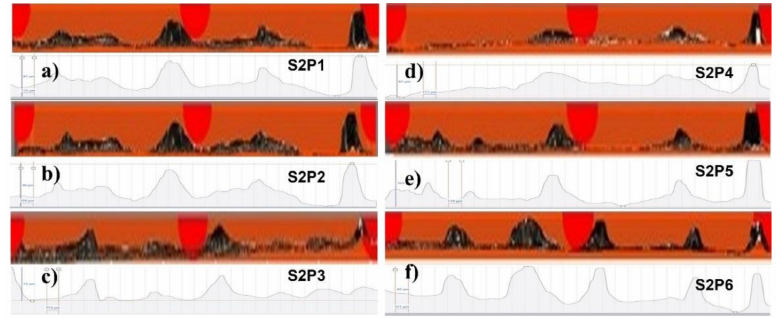
Figure 17. Peripheral morphology of ( a ) S2P1, ( b ) S2P2, ( c ) S2P3, ( d ) S2P4, ( e ) S2P5, and ( f ) S2P6.